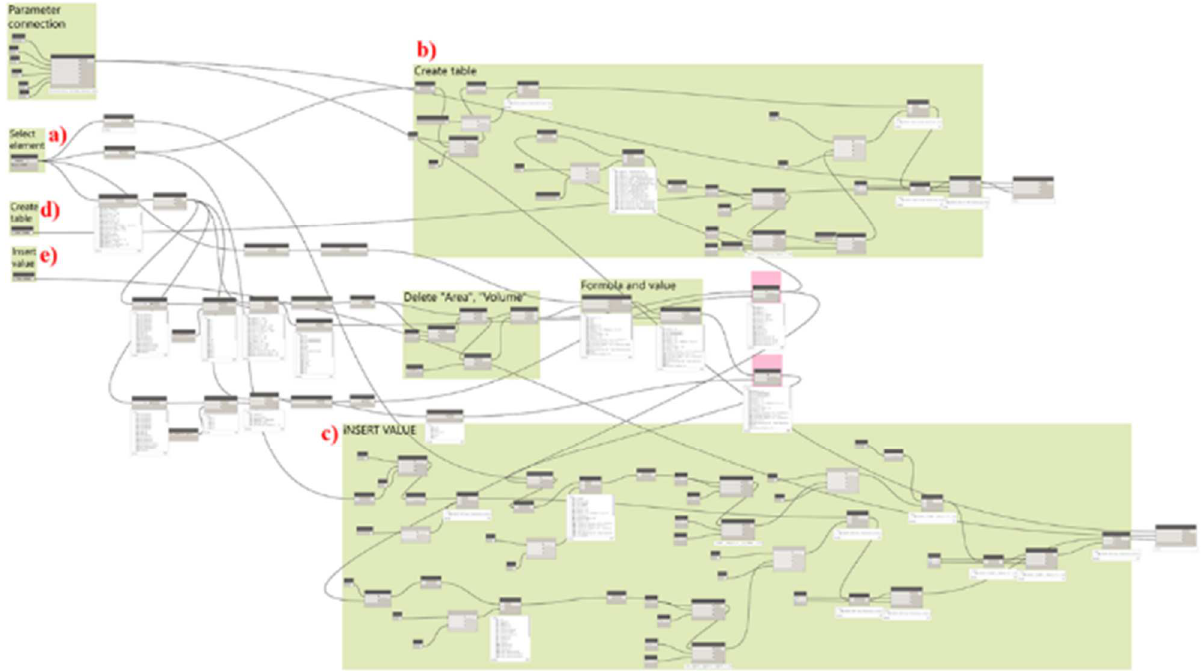
Figure 6.Workflow sequence for creating the type family table and entering values for the selected element: a) selection element; b) Generation of MySQL string for creating the table; c) Generation of MySQL string for entering values; d) and e) keys for running the script.